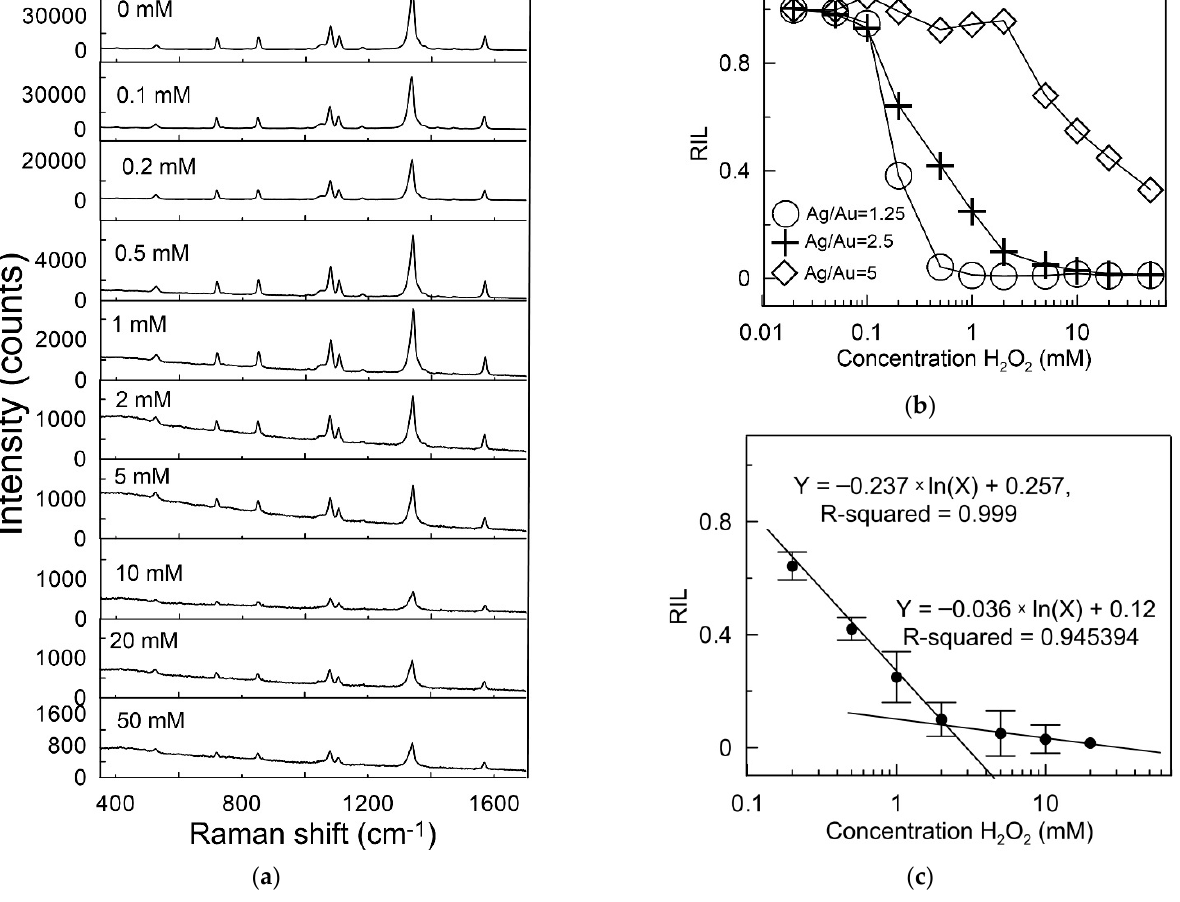
Figure 5. ( a ) The Au@Ag nanoparticles’ SERS spectra were measured after incubation with H 2 O 2 at different concentrations. The data are given for nanoparticles obtained using Ag-to-Au molar ratio of 2.5; ( b ) the dependence of relative intensity loss (RIL) on the concentration of H 2 O 2 ; ( c ) two linear calibration curves by plotting the RIL versus different concentrations of H 2 O 2 . within 0.1–2 mM and 2–20 mM.